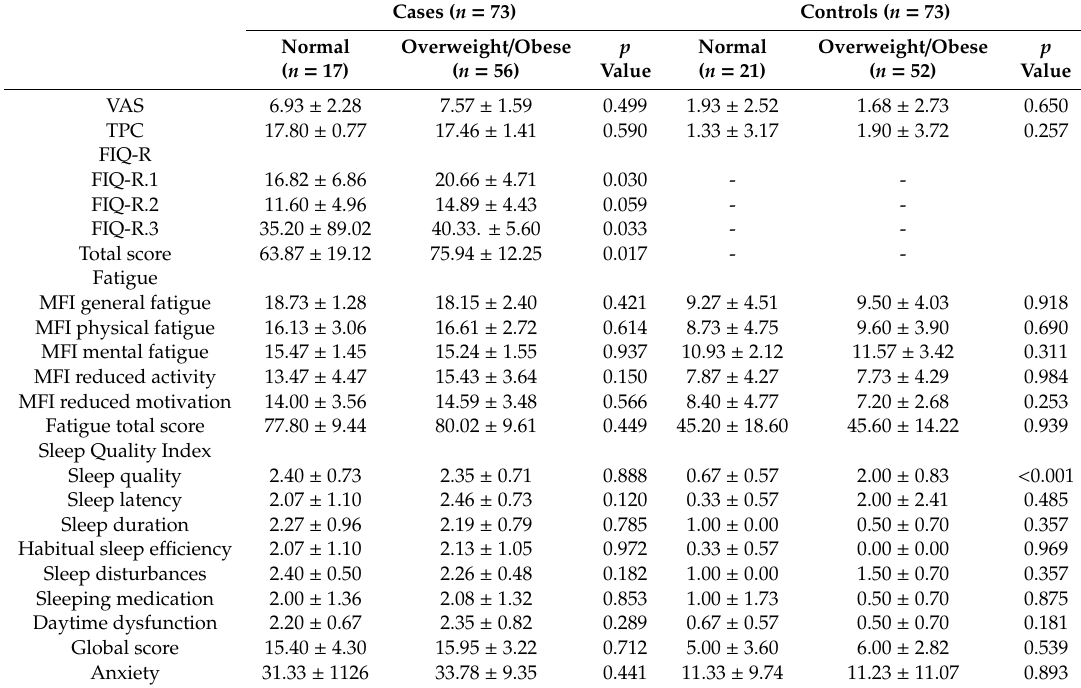
Table 2. Comparison of clinical data between normal weight and overweight / obese women with fibromyalgia and healthy